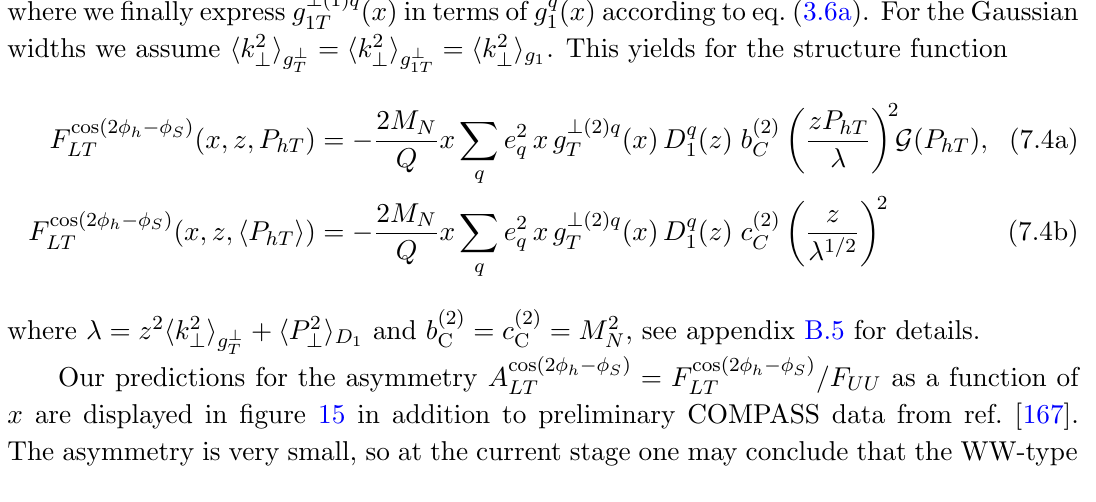
as function of x from scattering of 160 GeV LT